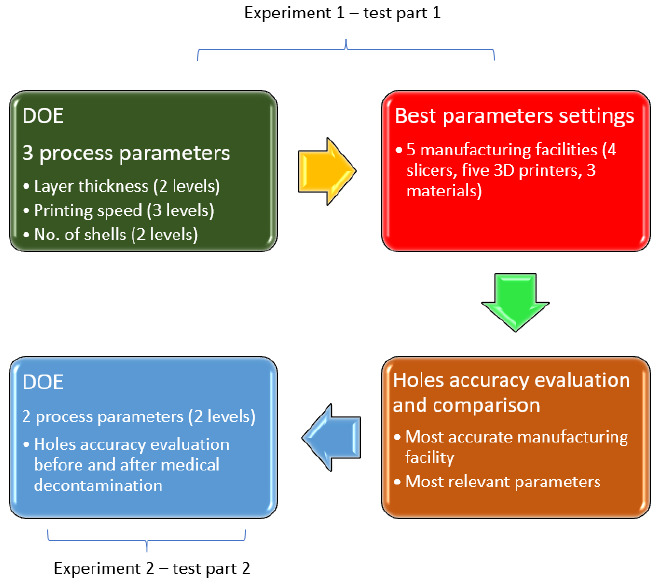
Figure 1. Schematic representation of the research methodology.